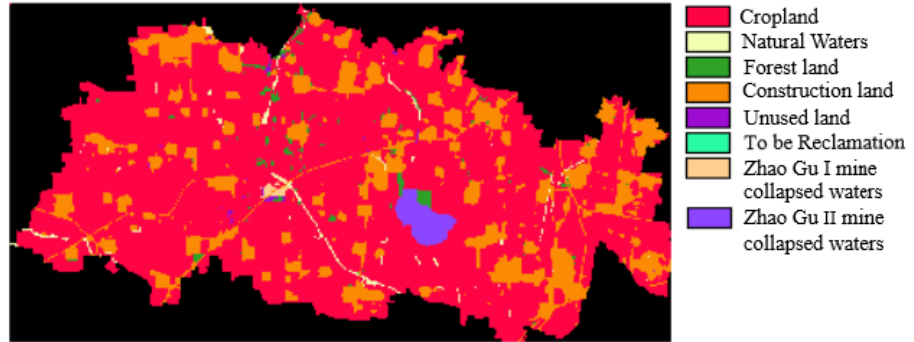
Figure 5. Simulation map of the spatial distribution pattern of landscape types in 2019.